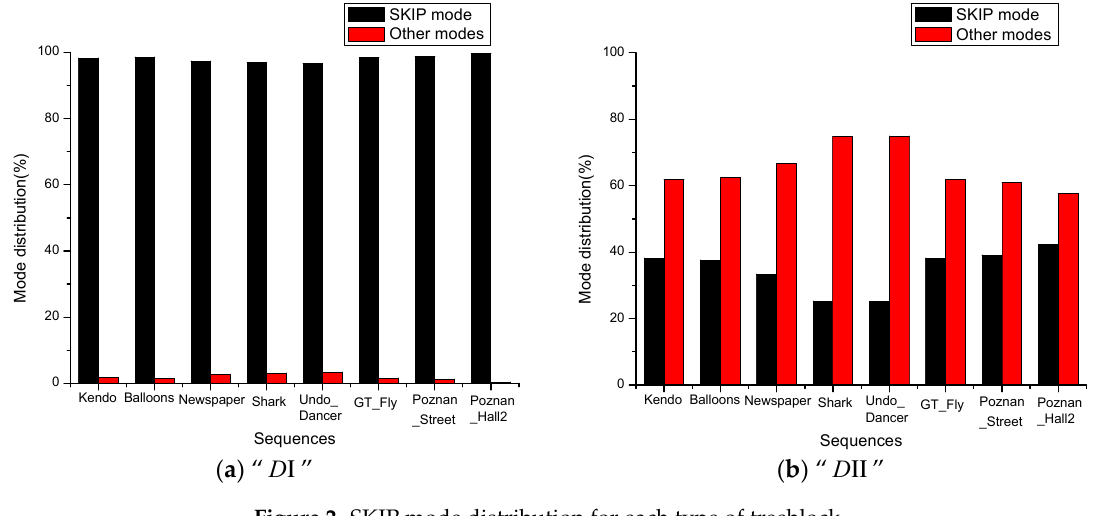
Figure 2. SKIP mode distribution for each type of treeblock.